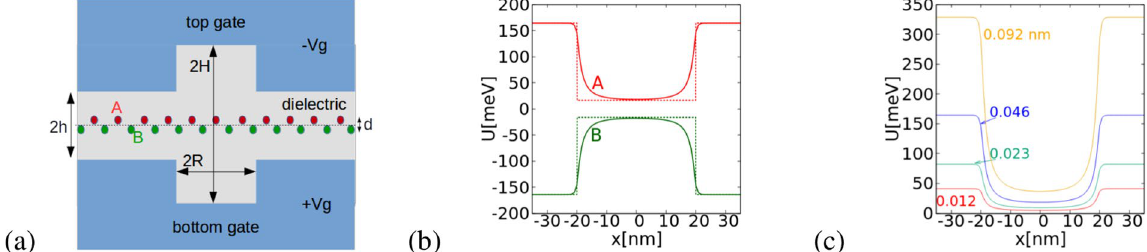
Figure 1. ( a ) Schematics of the quantum dot device. The silicene layer is embedded within a dielectric inside a symmetric double gate system. The distance between the A and B sublattice planes is d = 0.046 nm. The spacing between the gates within the central circular region of diameter 2 R = 40 nm is 2 H = 28 nm and 2 h = 2.8 nm outside. ( b ) The solid lines show the electrostatic potential for V g = ± 10 V applied to the gates at the A and B sublattices as calculated from the Laplace equation. The dashed lines indicate a rectangular quantum well approximation used in the calculations (see text). The cross section of the electrostatic potential in ( b ) is taken at y = 0 and z = ± d /2. ( c ) The potential on the A sublattice for the parameters of ( b ) for varied buckling, i.e. the vertical offset between the A and B sublattices with the values of d given in the plot in nanometes. The calculations in this work are performed for d = 0.046